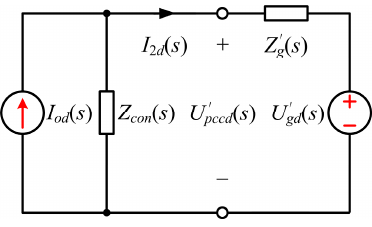
Figure 8. Equivalent circuit of grid-connected system.